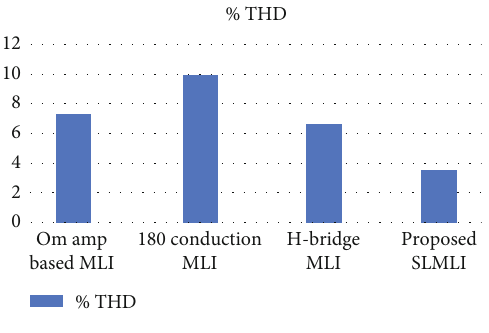
Figure 42: Comparison of